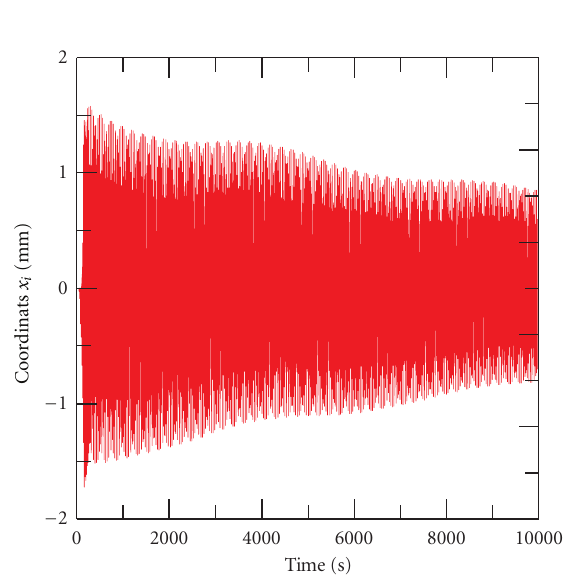
Figure 16: Long-term histories of ω 2 .